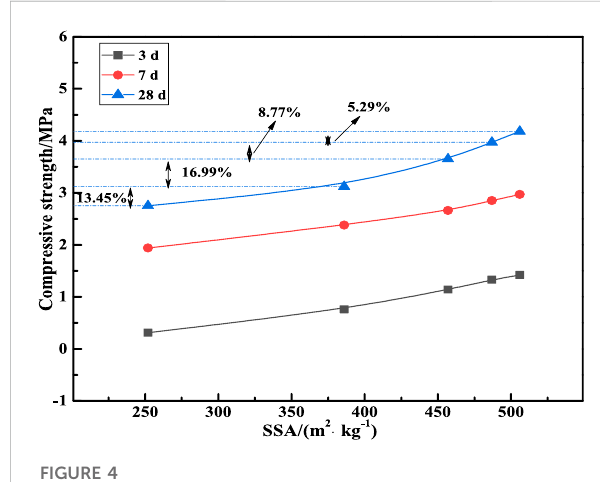
FIGURE 4 Effect of SS fi neness on the mechanical properties of BFPBM at different curing